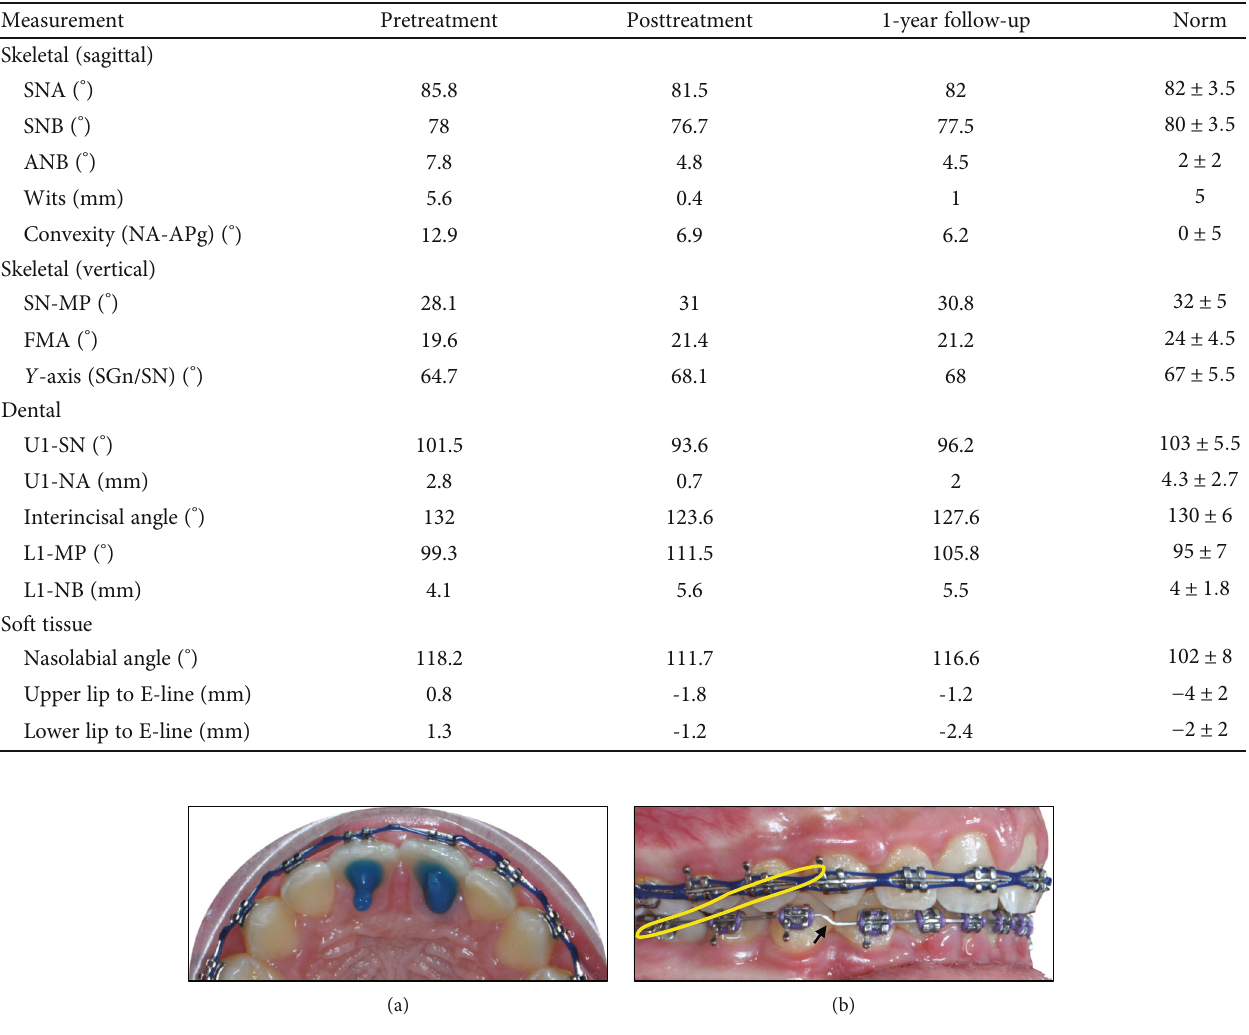
Table 1: Cephalometric measurements.